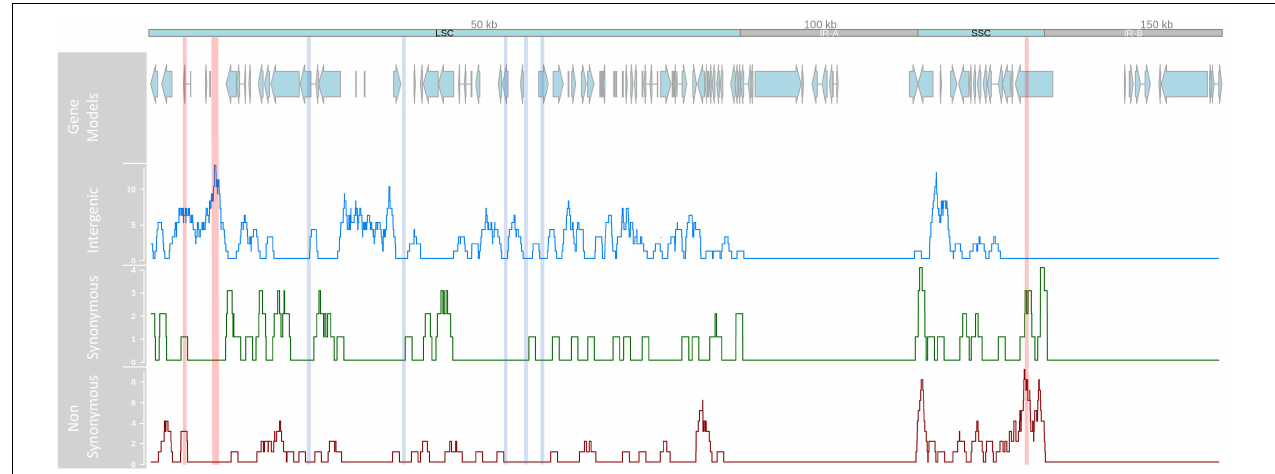
FIGURE 2 | Linear representation of the Macadamia integrifolia chloroplast genome. Tracks from top to bottom show the position of protein-coding gene models in the large single copy (LSC), small single copy (SSC) and inverted repeat (IR-A, IR-B) regions, and location and number of intergenic, synonymous, and non-synonymous SNP/kb using a sliding 100 kb window. Vertical lines indicate regions of high (10–11 SNP/kb in red) and low (0 SNP/kb in blue) SNP density.